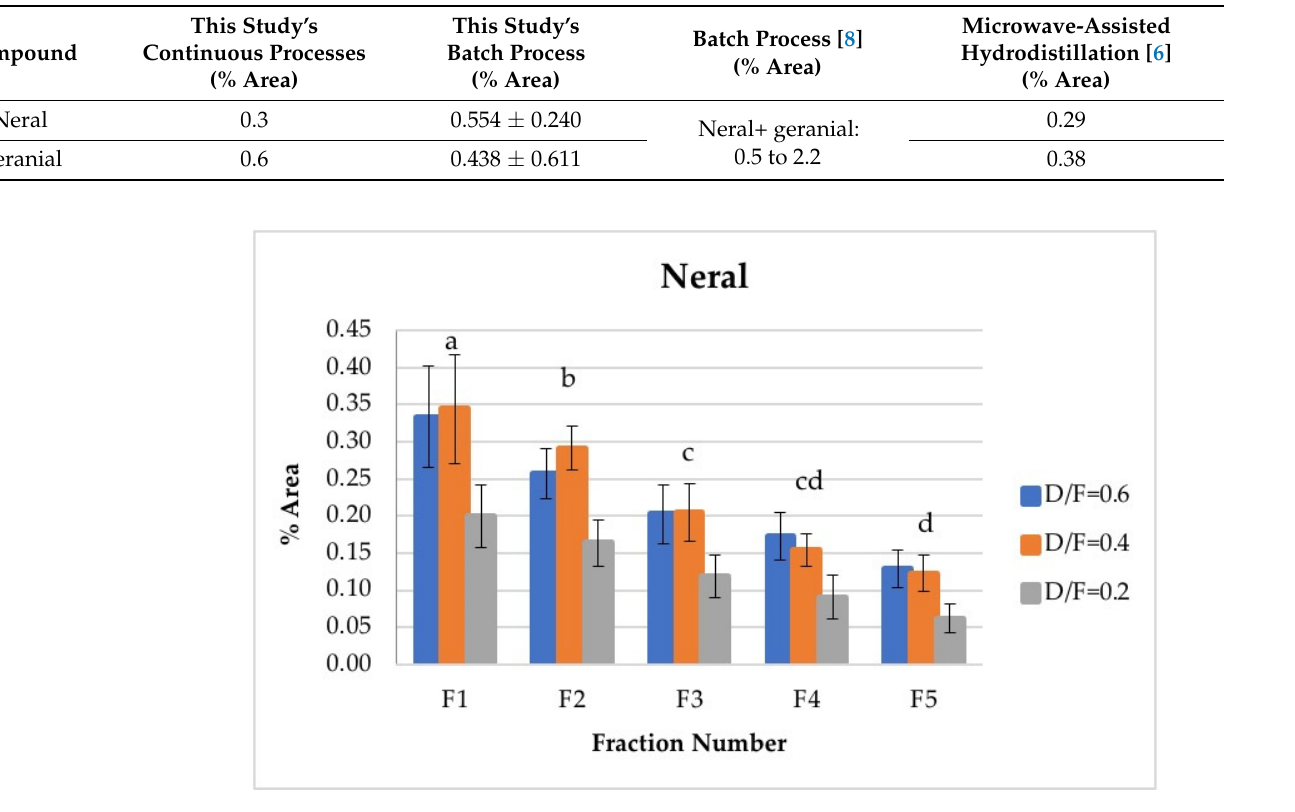
Figure 13. Abundance profile vs. number fraction for geranial. The results are the average of three replicates ± standard deviation. Different letters over a column indicate statistical differences (Tukey, p < 0.05). The fractions presented significant differences in the composition of minority com- pounds able to affect the aroma of essential oil fractions. Further studies are required at other residence times to evaluate the effects of these compounds on composition. 2.4.2. Effect of D/F on the Relative Abundance of Compounds The D/F had an effect on d-limonene, with statistically significant differences ob- served at 95% confidence in the abundance of the seven monitored compounds because of the effect of the D/F ratio. D-limonene, γ -terpinene, α -terpineol, neral, and geranial were presented as two ho- mogeneous groups. The first homogeneous group (group a) included a D/F ratio of 0.2,